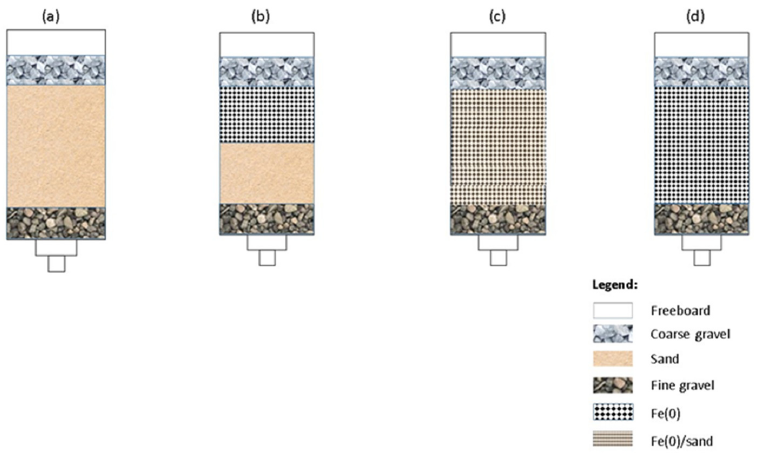
Figure 2. Sketch of layered and mixed Fe 0 /sand filters for water treatment: ( a ) sand alone (reference), ( b ) layered Fe 0 /sand, ( c ) mixed Fe 0 /sand, and ( d ) Fe 0 alone (negative reference). 2.2. Investigating the Remediation Fe 0 /Aggregate Filtration System